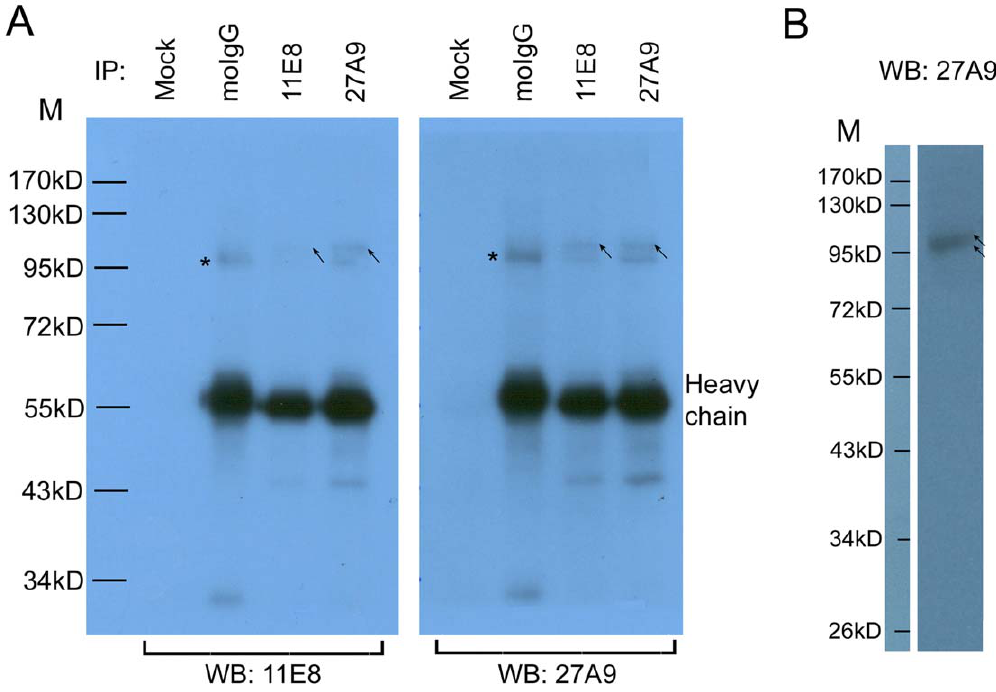
Figure 3. Detection of the native SjAgo2 protein by Western blot. A . Detection of the native SjAgo2 protein in different SWAP immunoprecipitates. Lanes 1 and 5, no antibody added; lanes 2 and 6, immunoprecipitated by normal mouse IgG; lanes 3 and 7, immunoprecipitated by mAb 11E8; lanes 4 and 8, immunoprecipitated by mAb 27A9. Left panel, immunoprecipitates were detected by Western blot with mAb 11E8. Right panel, immunoprecipitates were detected by Western blot with mAb 27A9. HRP-conjugated goat anti-mouse IgG was used as a secondary antibody. The arrows indicate the specific recognition of SjAgo2 by mAbs; the asterisks indicate the band recognized by normal murine IgG. B. SWAP was resolved by 12% SDS-PAGE and detected by Western blot with mAb 27A9. The arrows indicate the two bands recognized by mAb 27A9. M, prestained protein ladder SM0671.